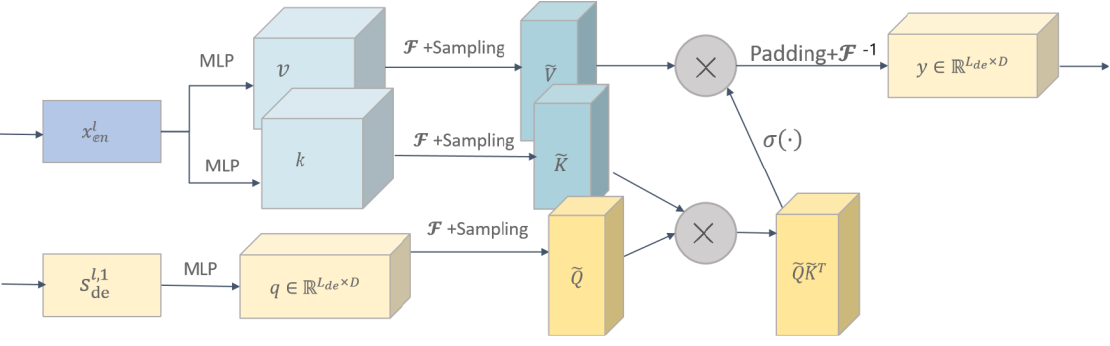
Figure 3. Frequency Enhanced Attention module.